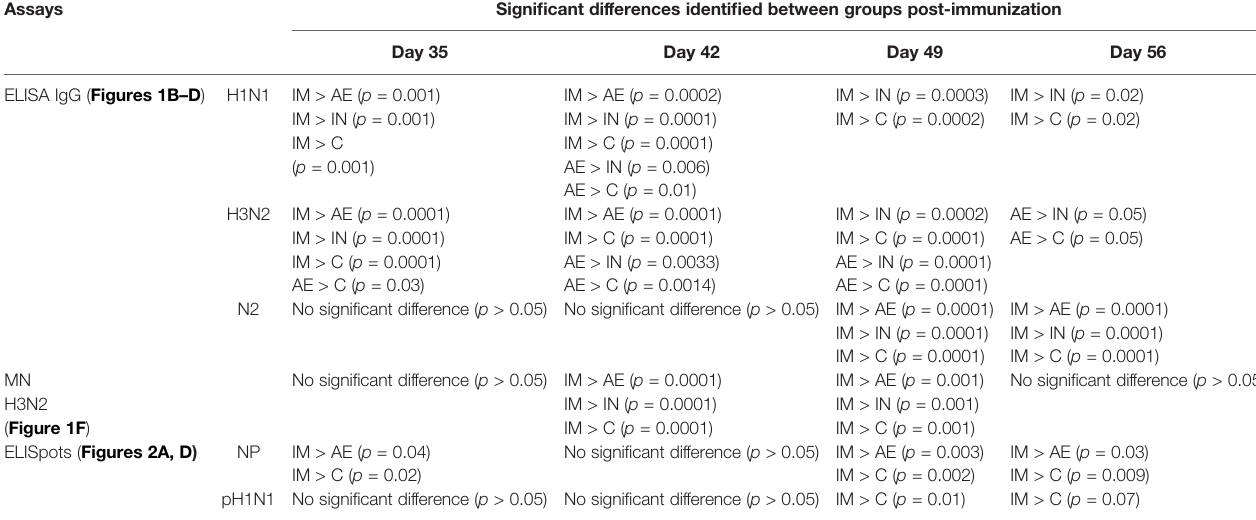
TABLE 2 | Signi fi cant differences between the four groups at the same time point after immunization. Assays